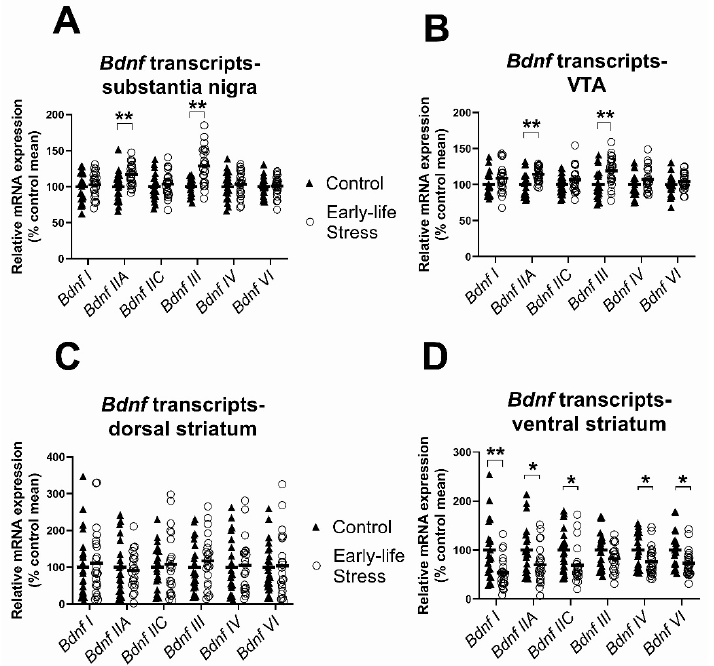
Figure 4. Effects of early life stress on BDNF transcript levels. ( A , B ) Maternally separated rats had higher levels of Bdnf IIA and III mRNAs in the substantia nigra and VTA than control rats; ( C ) there were no main effects of early life stress on Bdnf transcripts in the dorsal striatum; ( D ) maternally separated rats had lower levels of Bdnf I, IIA, IIC, IV and VI mRNAs in the ventral striatum than control rats. Data are expressed as a percentage of the control group mean. Each data point represents a single animal. Filled triangles and hollow circles represent control and early life stress animals, respectively. Horizontal lines depict group means. * p < 0.05, ** p < 0.005. Table 2. Two-way ANOVA showing main effects of sex, treatment and interaction between sex and treatment on Bdnf transcript levels in the ventral striatum of 22 control and 24 maternally separated rodents. Asterisks (*) indicate genes whose log-transformed data were used for statistical analysis. Bold type indicates statistically significant effects.